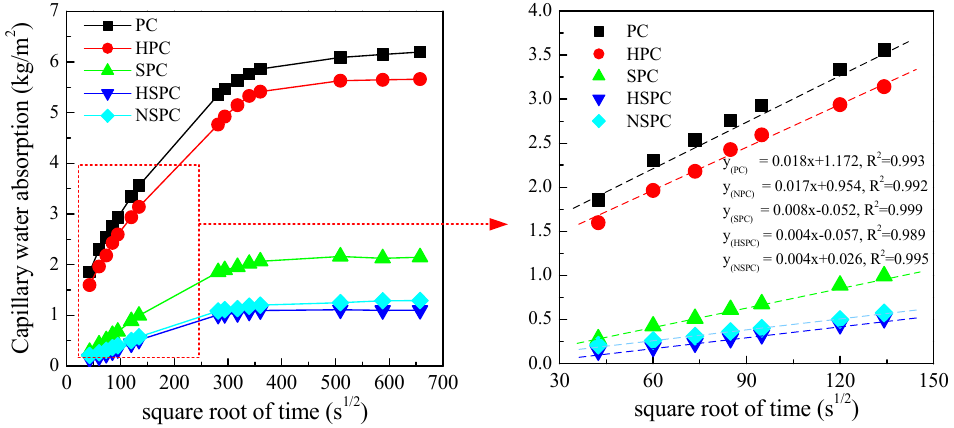
Figure 7. Capillary water absorption of the cement composites versus the square root of time.